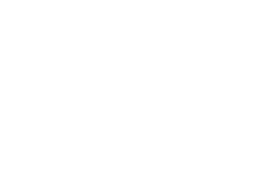
Figure 1. A schematic representation of the molecular structure of ( a ) phenyl boronic acid (PBA) and ( b ) cyclohexyl boronic acid (CHBA).